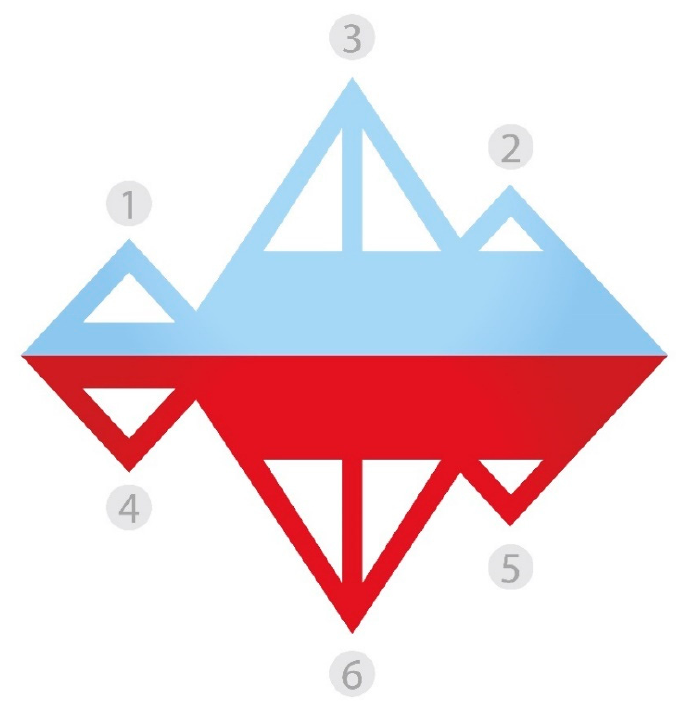
Figure 1. According to the model, there are six different stages of understanding. 1. Basic, principal stage (A) enables grasping of the principal meaning (quality of the world). The body analogue is skin. 2. High, essential stage (B) enables grasping of the essences of world phenomena (quiddity). The body analogue is flesh. 3. The highest, causal stage enables understanding causality (why). The body analogue is lungs and the skeleton. 4. An in-depth theoretical stage (C) enables understanding theoretical sense (how). The body analogue is the right atrium of the heart. 5. Profound, expert stage (D) enables understanding of professional identity (who). The body analogue is the left atrium of the heart. 6. The deepest, purposive stage enables understanding of purposiveness. The body analogues are the left and right ventricles of the heart.